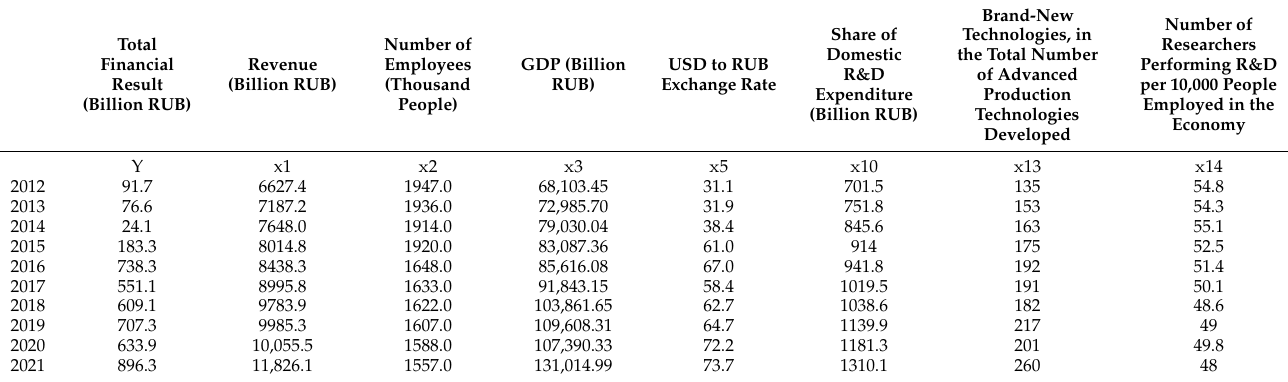
Table 3. Baseline data for regression analysis.